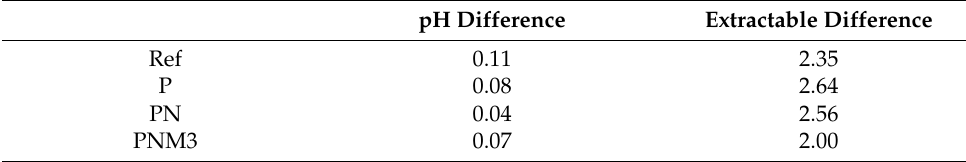
Figure 4. Absorbance of samples. Table 2. pH & Extractables test of